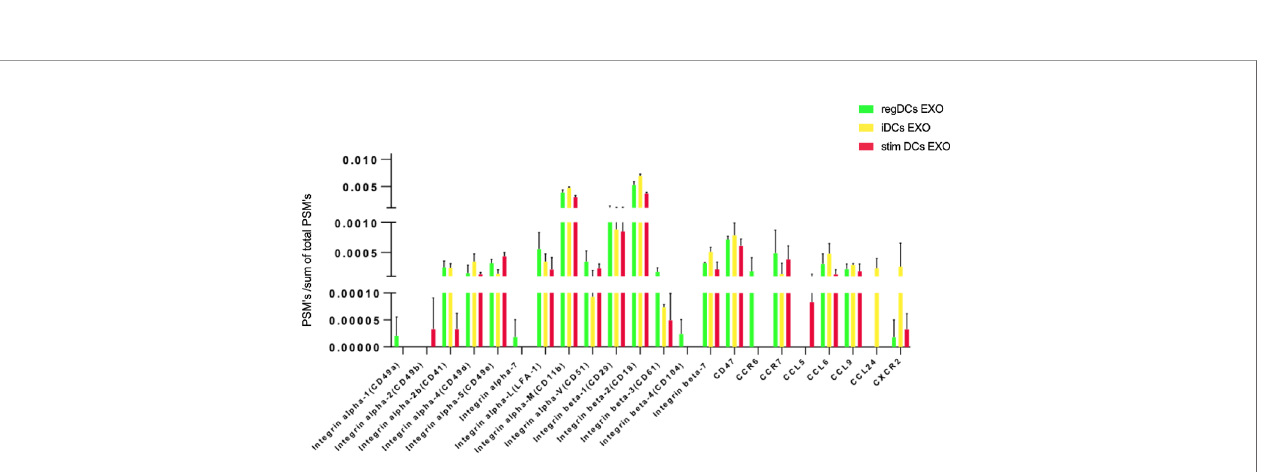
FIGURE 6 | Identi fi cation of integrins and chemotactic factors in DCs